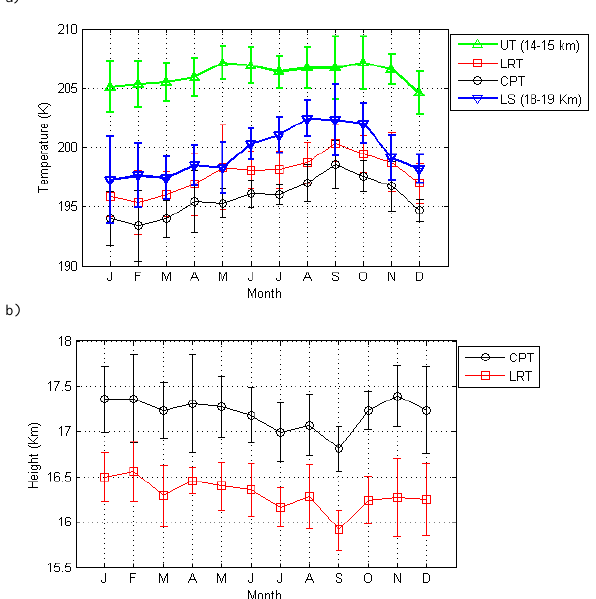
6 Figure 2: 7 Fig. 2. (a) Time evolution of monthly averaged temperature at UT (a) Time evolution of monthly averaged temperature at UT (14-15 km), LRT, CPT and LS 8 (14–15km), LRT, CPT and LS (18–19km) over Reunion derived (18-19 km) over Reunion derived from continuous observations during the period from 9 from continuous observations during the period from January 1993 January 1993 to December 2008. 10 to December 2008. (b) Time evolution of monthly averaged heights (b) Time evolution of monthly averaged heights of LRT and CPT over Reunion from the 11 of LRT and CPT over Reunion from the same period of observations same period of observations as (a) . 12 as